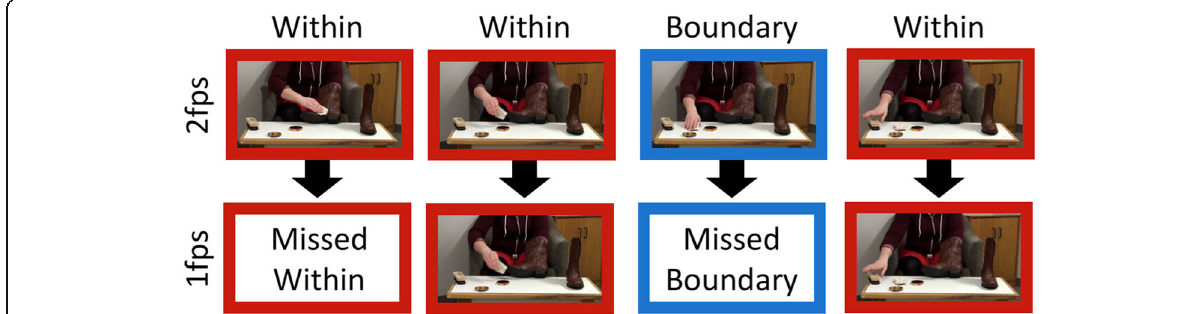
Fig. 1 Selected images from the boot polishing slideshow classified as boundary and within-unit slides. This sequence of images illustrates the consequence of removing every other slide from the 2-fps slideshow to create a 1-fps